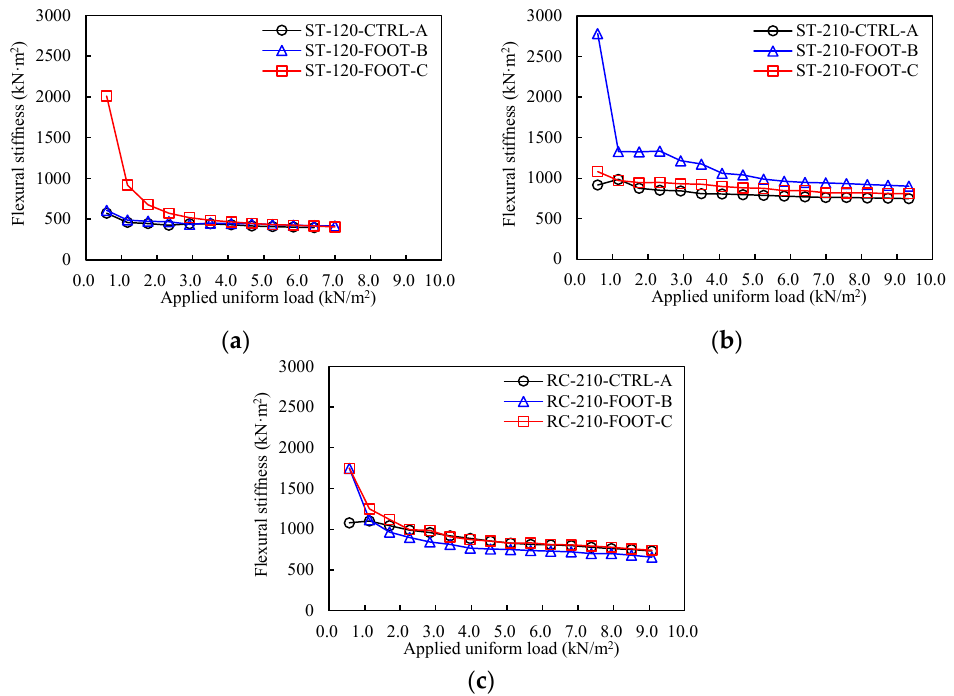
Figure 8. Flexural stiffness based on loading steps. ( a ) Group-1. ( b ) Group-2. ( c ) Group-3.